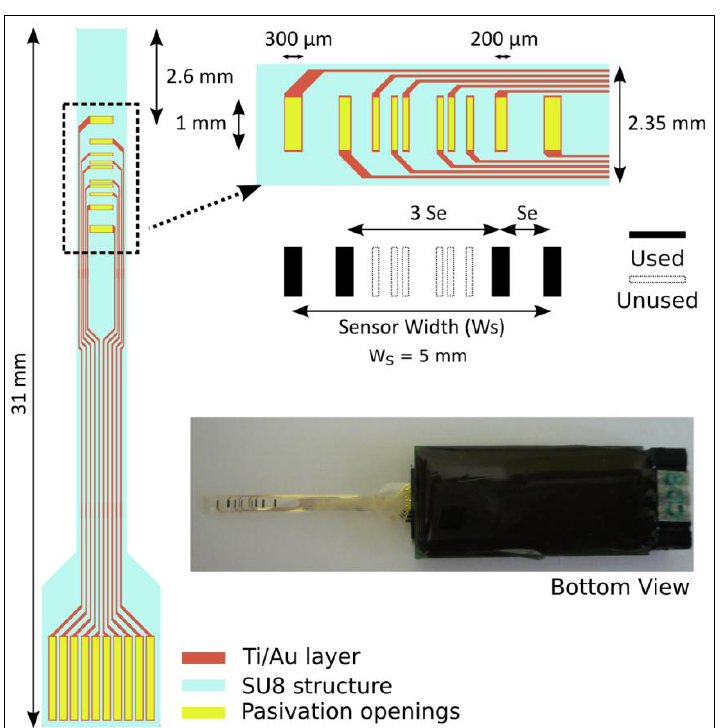
Figure 2. Sketch of the flexible sensor device and bottom image of the packaged sensor ready to be used with the 5 mm electrode